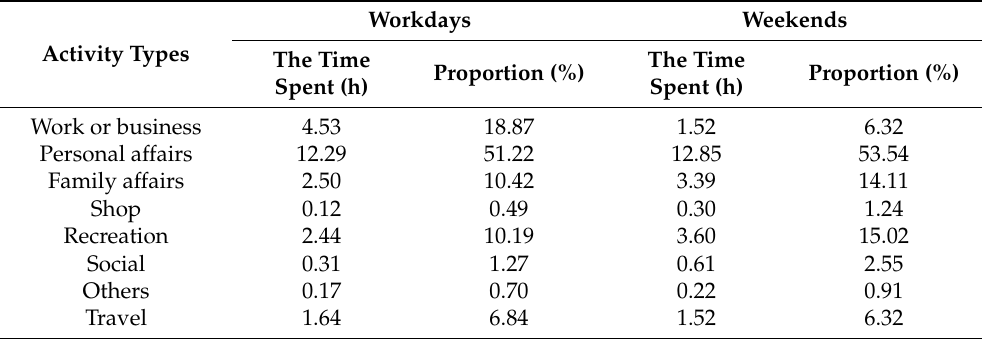
Table 2. The relationship between activity type and the time spent of residents on workdays and week-